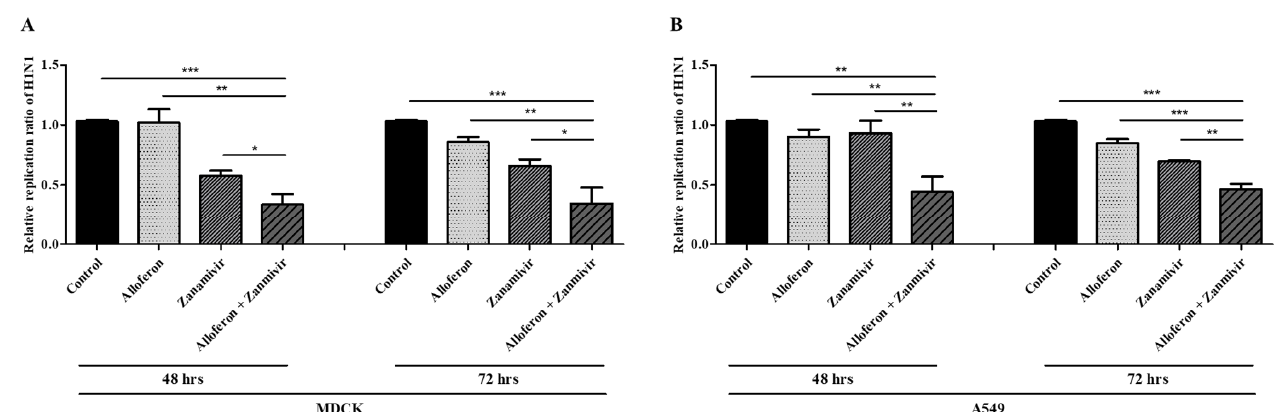
Figure 1. Alloferon increased the antiviral efficacy of zanamivir after infection with H1N1. Quantitative real-time PCR analysis of the levels of influenza virus (normalized to GAPDH) was performed in the presence or absence of alloferon (0.5 µ g/mL) and zanamivir (35 µ g/mL). Briefly, cells were infected with influenza A virus (MOI 0.01), extraction of total RNA was performed, and RT-PCR was performed using primers specific for H1N1. The amount of virus in treated cells is shown relative to that in control cells (cells infected with virus but not treated). Results are representative of more than three independent experiments. Control: Virus only ( A ) MDCK ( B ) A549 * p < 0.1, ** p < 0.01, *** p < 0.001, NS; not significant.